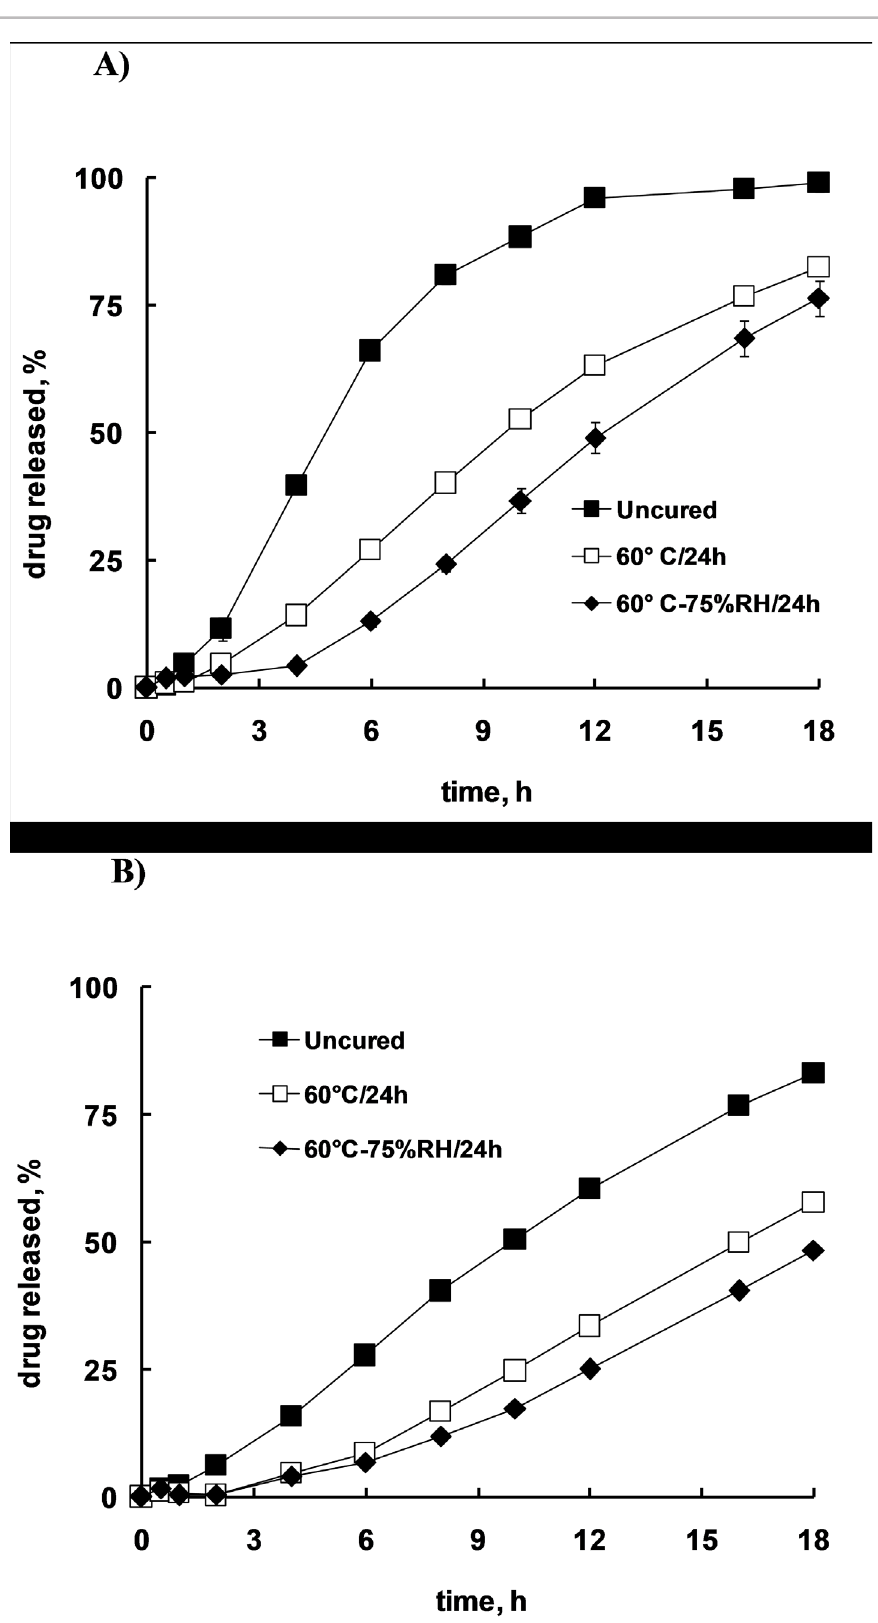
FIGURE 1 - Effect of curing on drug release from pellets based on sugar cores loaded with 10% proranolol HCl and coated with: A) Aquacoat ® ECD using TEC 25% and Talc 35%, B) Eudragit ® NE 30D using Talc 35%, coating level